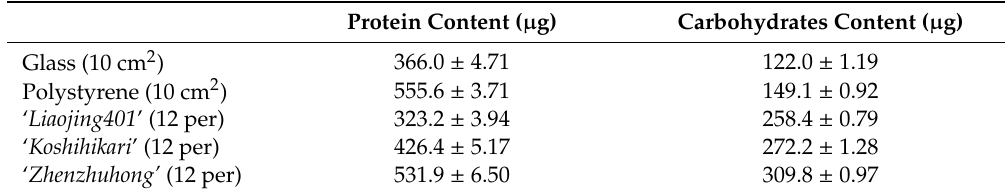
Table 2. The protein content and carbohydrate content in the extracellular matrix of biofilm formed on di ff erent surfaces were determined by Bradford method and phenol sulfuric acid method. Data are shown as mean ±